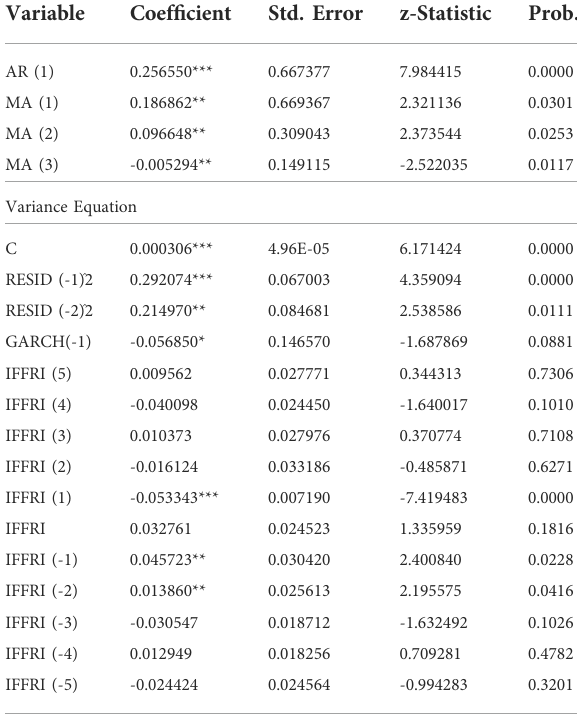
TABLE 8 Robustness test result (IFFRI factor not added). TABLE 9 Robustness test result (IFFRI factor is